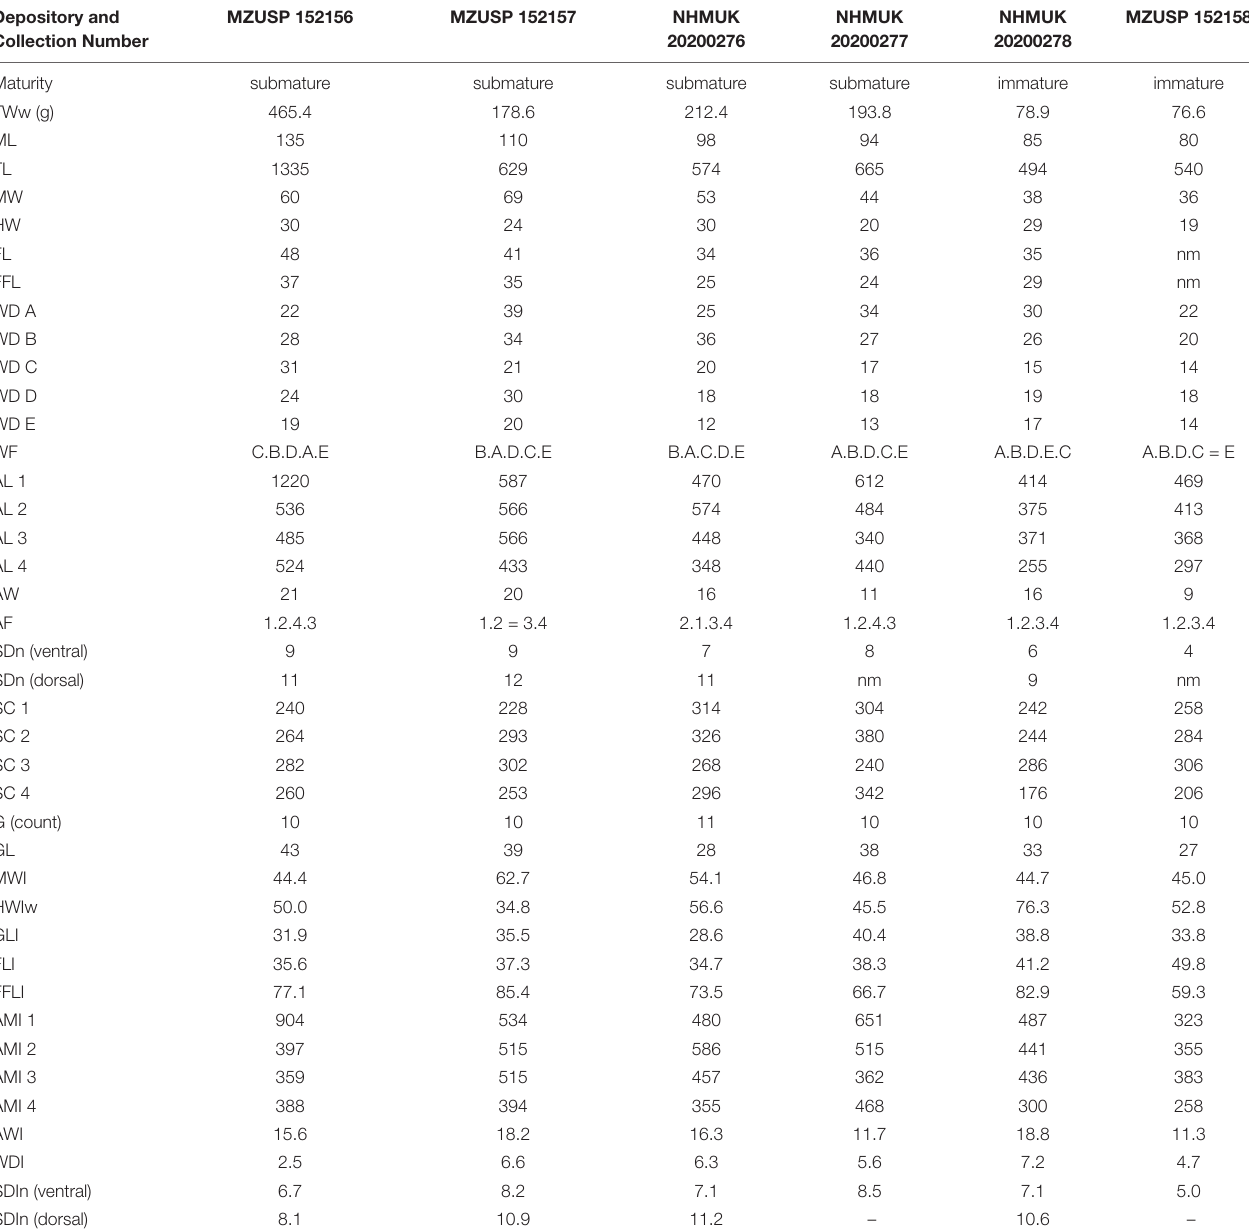
TABLE 4 | Callistoctopus furvus measurements (mm), counts and indices for preserved females (voucher specimens). Depository and Collection